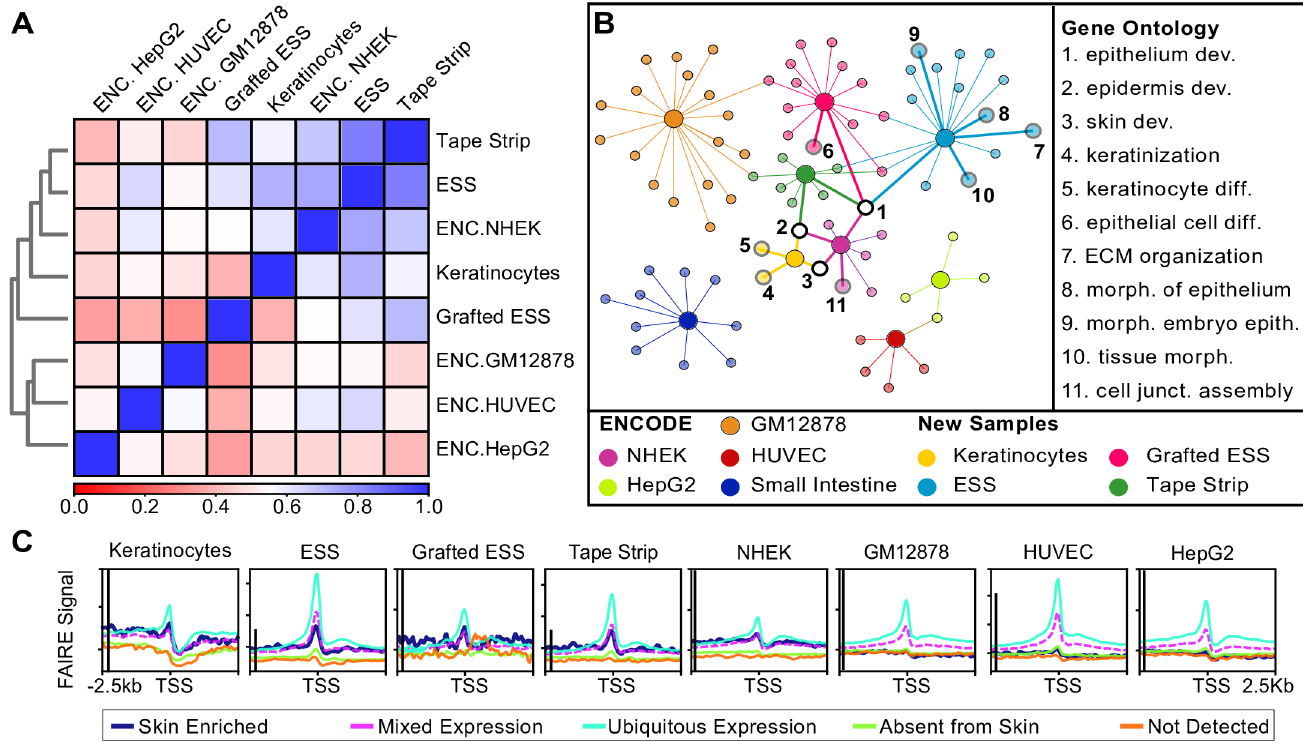
Fig 2. Global functional analysis of FAIRE signal and peaks. (A) Correlationmatrix of FAIRE signal profilesin keratinocytes, ESS, Grafted ESS, Tape-strippedgraft, and ENCODE NHEK, HUVEC, HepG2, and GM12878, using deepToolsmultiBigwigSummary. Blue representsperfect overlap, red indicates no correlation(see key). (B) ToppCluster analysisof the genes annotated to each FAIRE peak in Keratinocytes (yellow),ESS (light blue), Grafted ESS (pink), Tape-strippedESS (dark green) and ENCODE NHEK (purple),HepG2 (light green), Small Intestine (dark blue), HUVEC (red), and GM12878 (orange)samples. Genes present in all samples were filtered out prior to analysis. Large circles represent an input sample and smaller circles represent GO terms. GO terms related to epidermal development are numberedand identified. (C) FAIRE signal within +/- 2.5kb of the transcription start site (TSS) of Human Protein Atlas lists of genes elevatedin skin (dark blue), with mixed expressionpatterns that includeskin (pink), expressedin all tissues (light blue), not expressedin skin (green), and not detected in any tissue type (orange).The y-axis scales on the ESS, Tape-strip, and HUVEC graphswere adjustedto better displaythe data. The black line to the right of the axis represents 3 arbitrary units of data coveragein each graph. Abbreviations: ENC- ENCODE; dev.- development; diff.- differentiation; ECM- extracellular matrix; morph.- morphogenesis;junct.-junction; epith.-